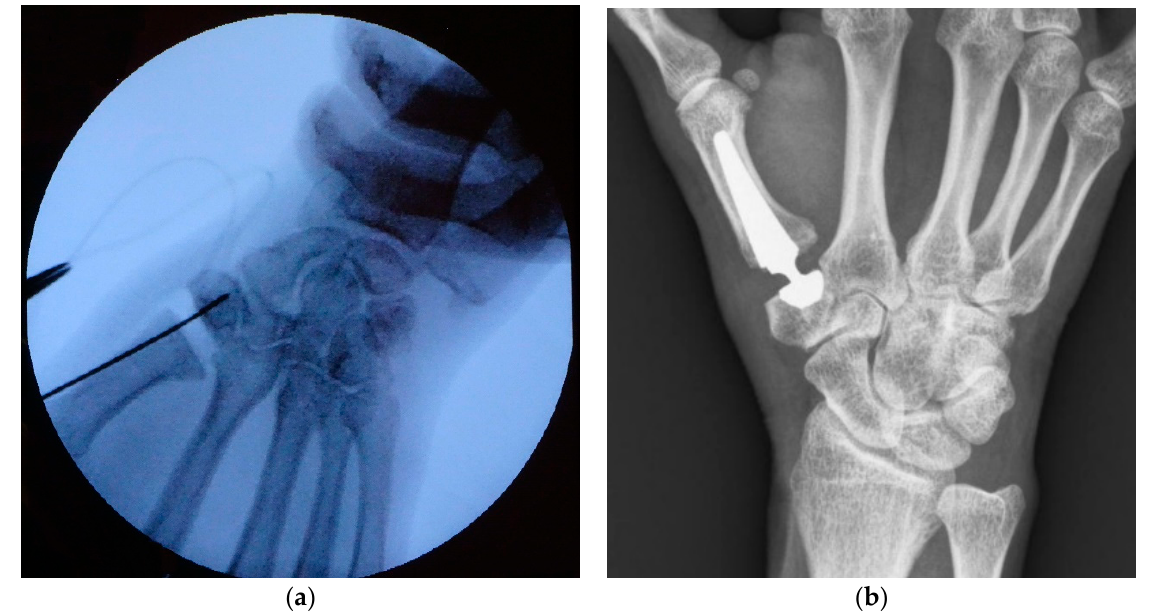
Figure 2. Intraoperative fluoroscopy showing Kirschner wire positioning before reaming ( a ); X-ray of TOUCH ® prosthesis taken at 1 year follow-up ( b ).